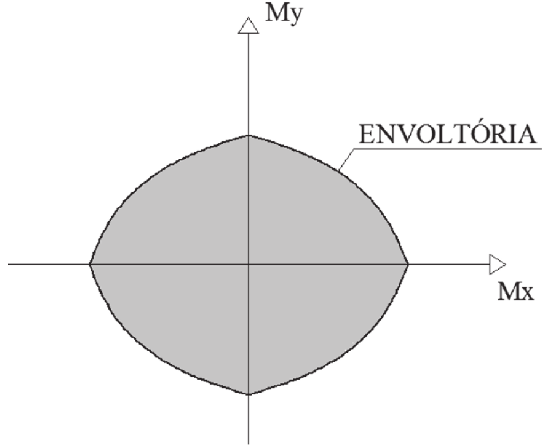
Exemplo de envoltória de esforços resistentes